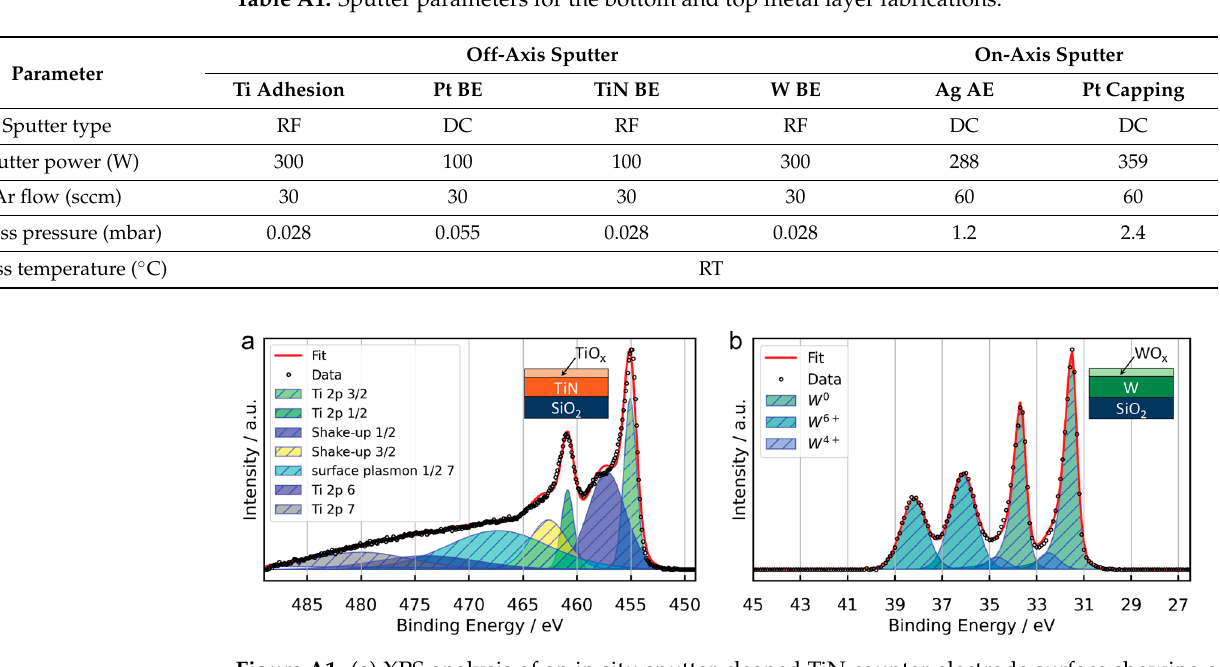
Figure A1. ( a ) XPS analysis of an in situ sputter-cleaned TiN counter-electrode surface showing a pure TiN surface. The sample was measured under a take-off angle of 45 ◦ . ( b ) XPS analysis of a pure W film under a take-off angle of 15 ◦ targeting the bulk of the film. Both measurements confirmed that the native oxide is formed only at the surface of the counter electrode.